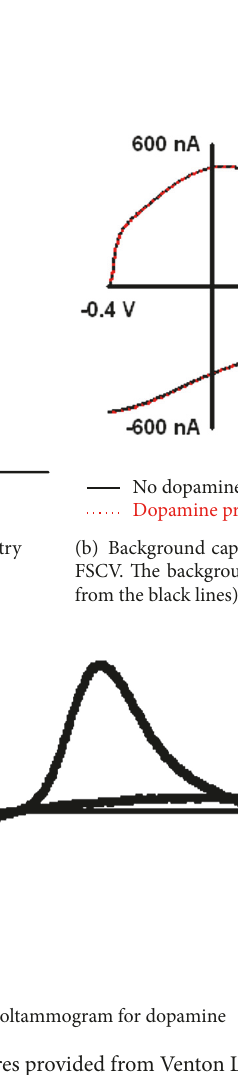
Figure 1: Figures provided from Venton Lab.